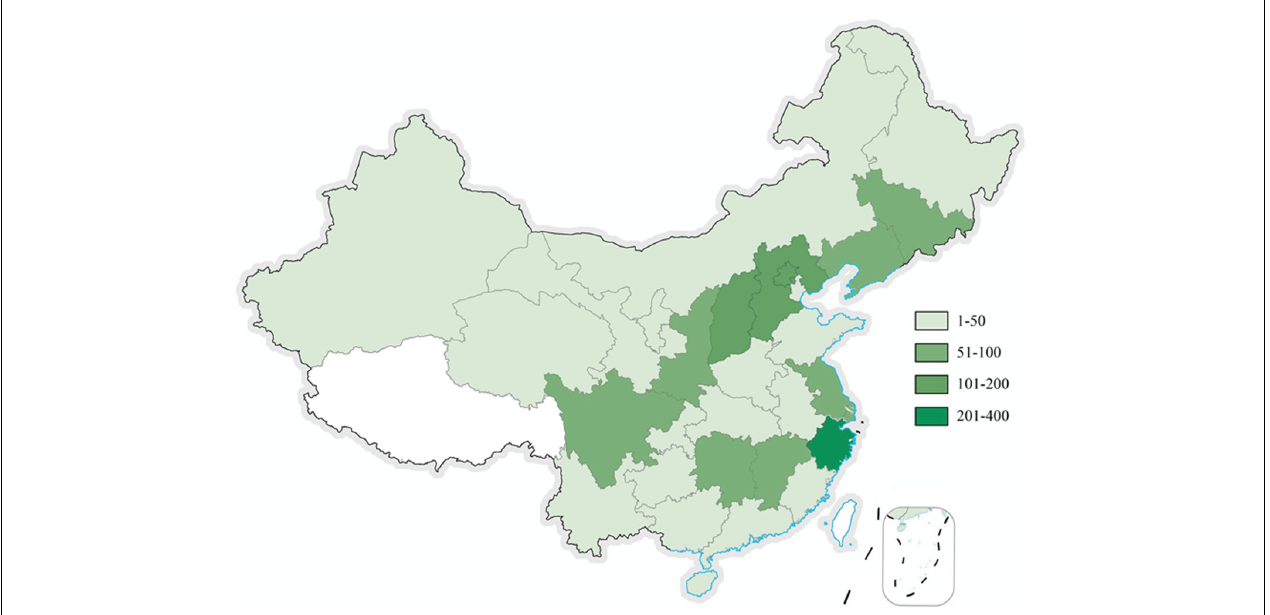
FIGURE 1 | Geographical distribution of participants in the current